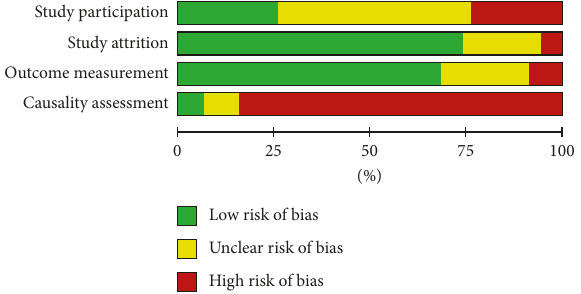
Figure 2: Risk of bias for all the included